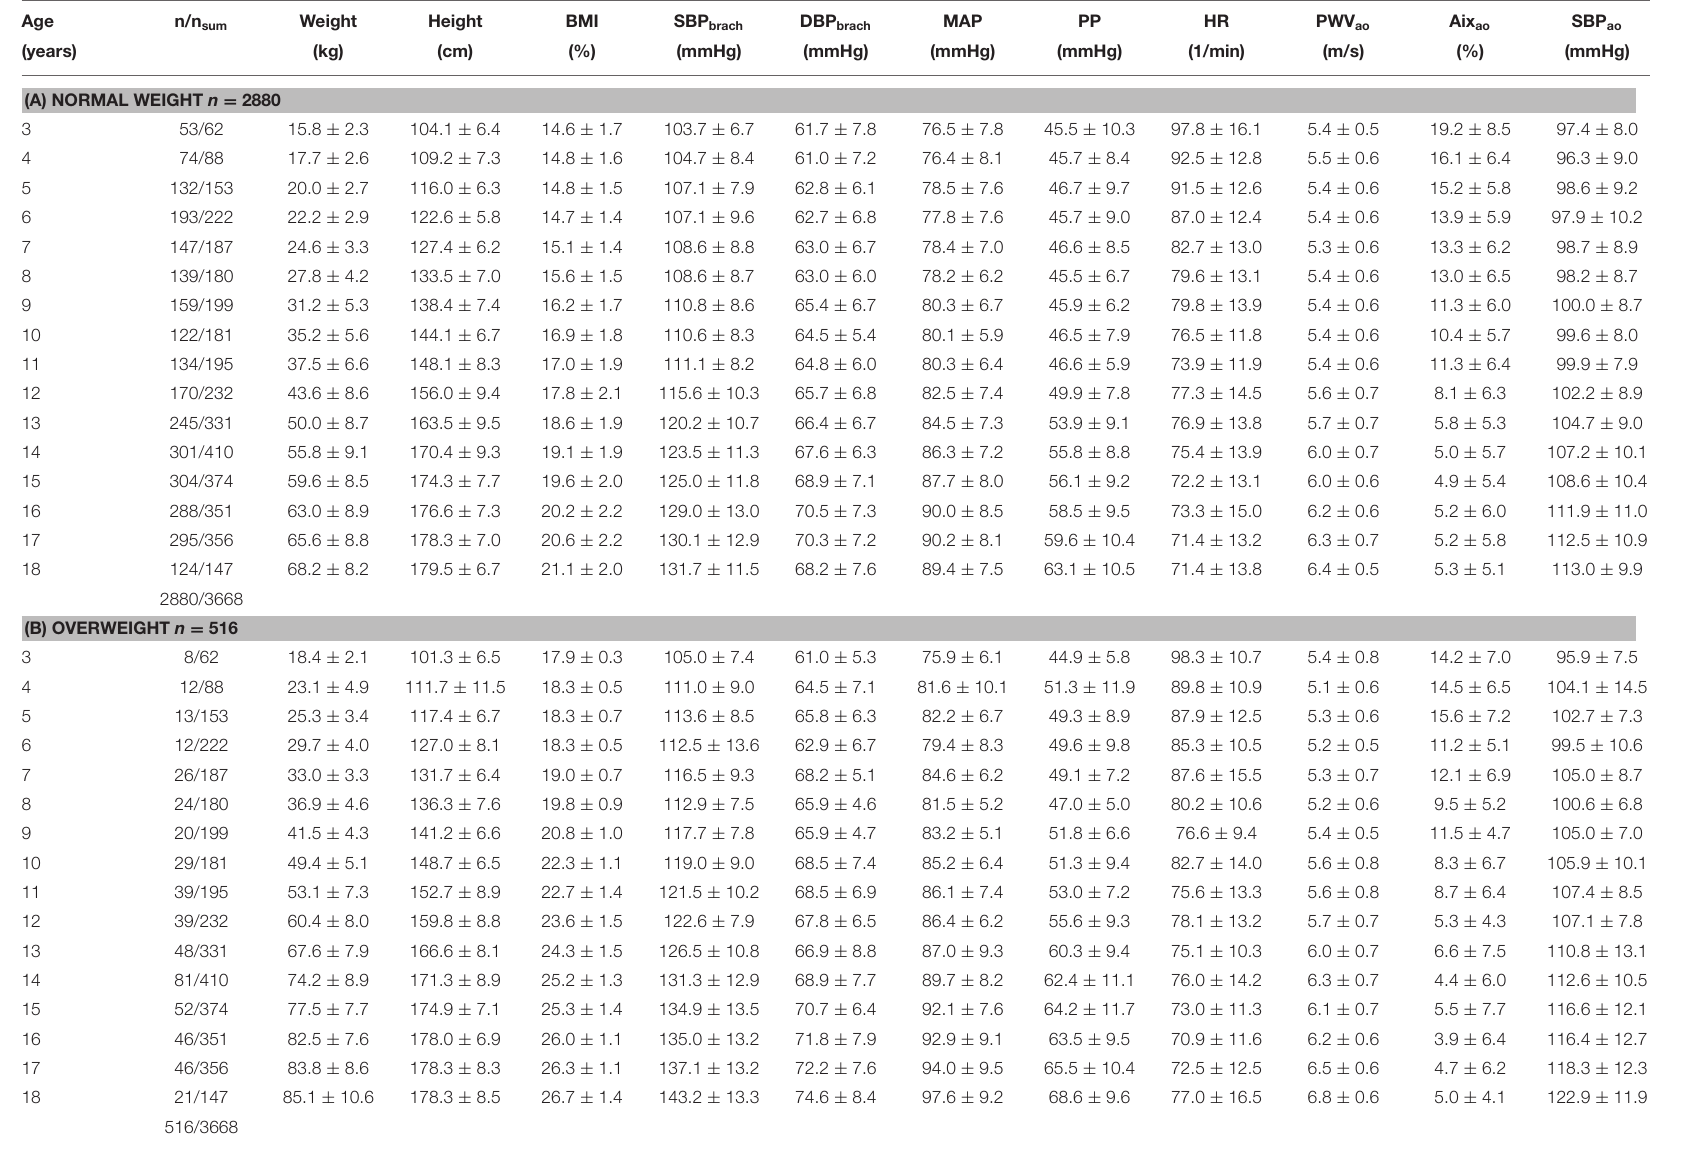
TABLE 1 | Characteristics for